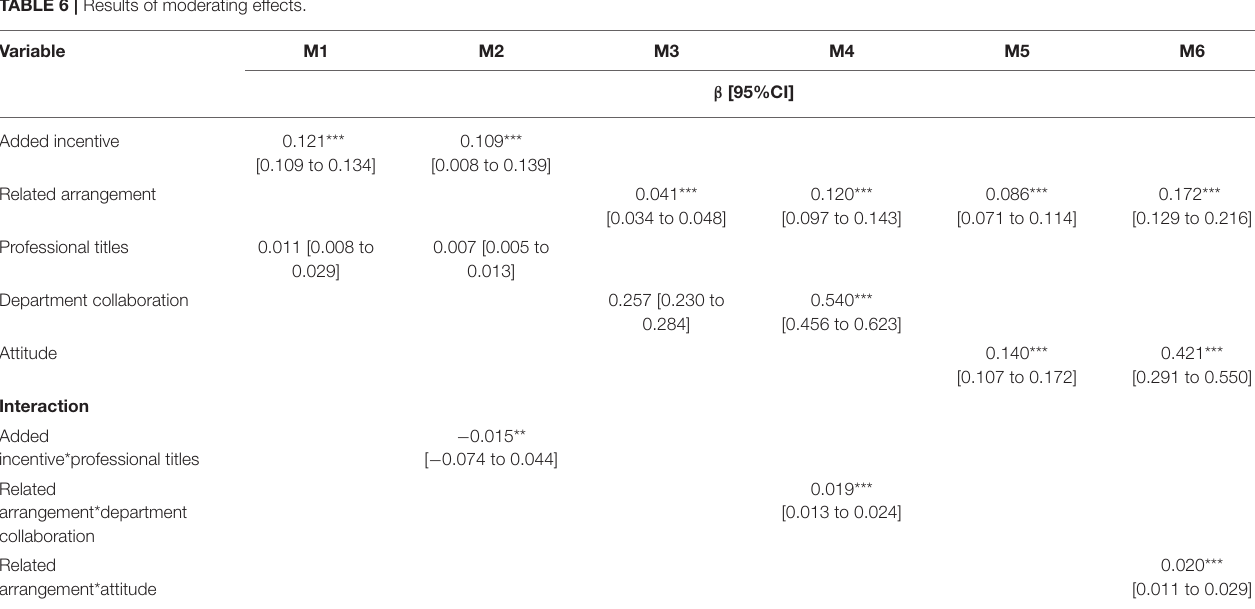
TABLE 6 | Results of moderating